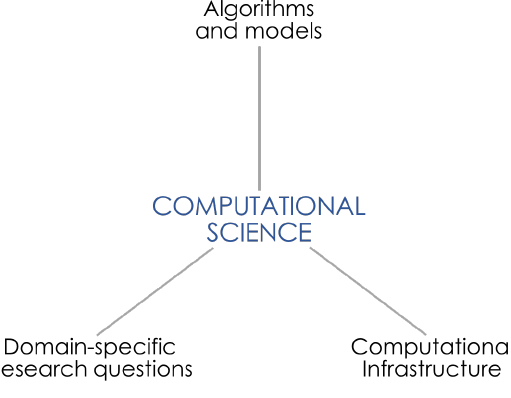
Figure 1. Computational science structure. A similar vision is proposed in: